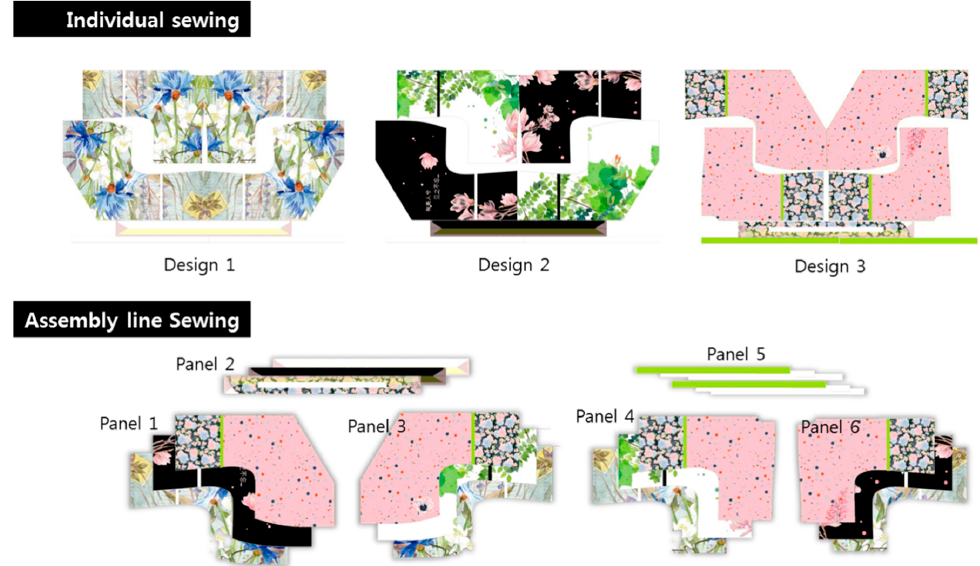
Figure 17. Panel classification scheme by sewing method: Line sewing and single piece flow production.